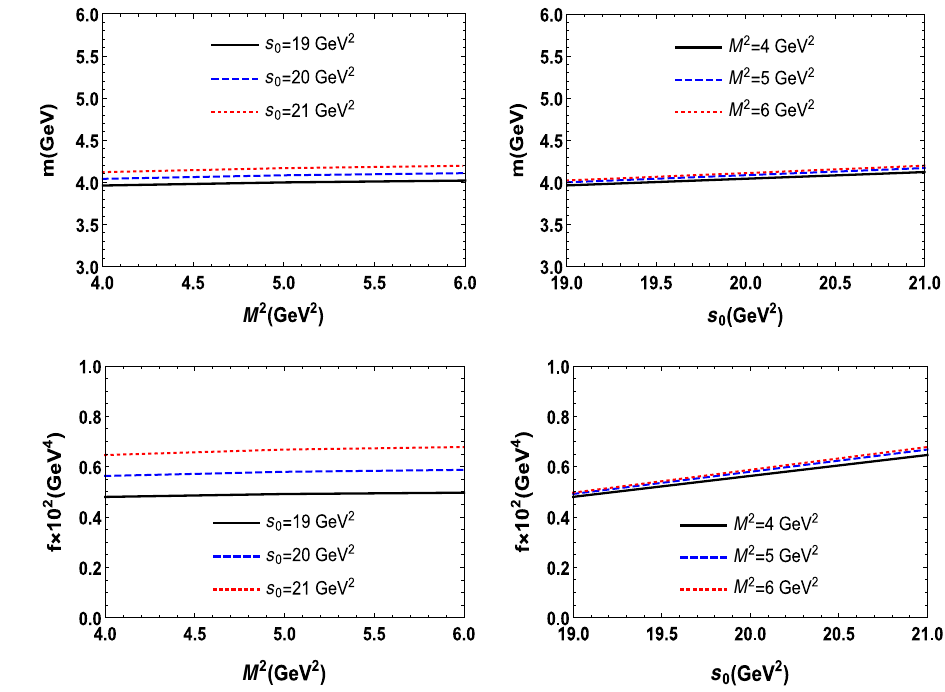
Fig. 1 The mass of the state Z − c ( 4100 ) as a function of the Borel parameter M 2 at fixed s 0 (left panel), and as a function of the continuum threshold s 0 at fixed M 2 (right panel)